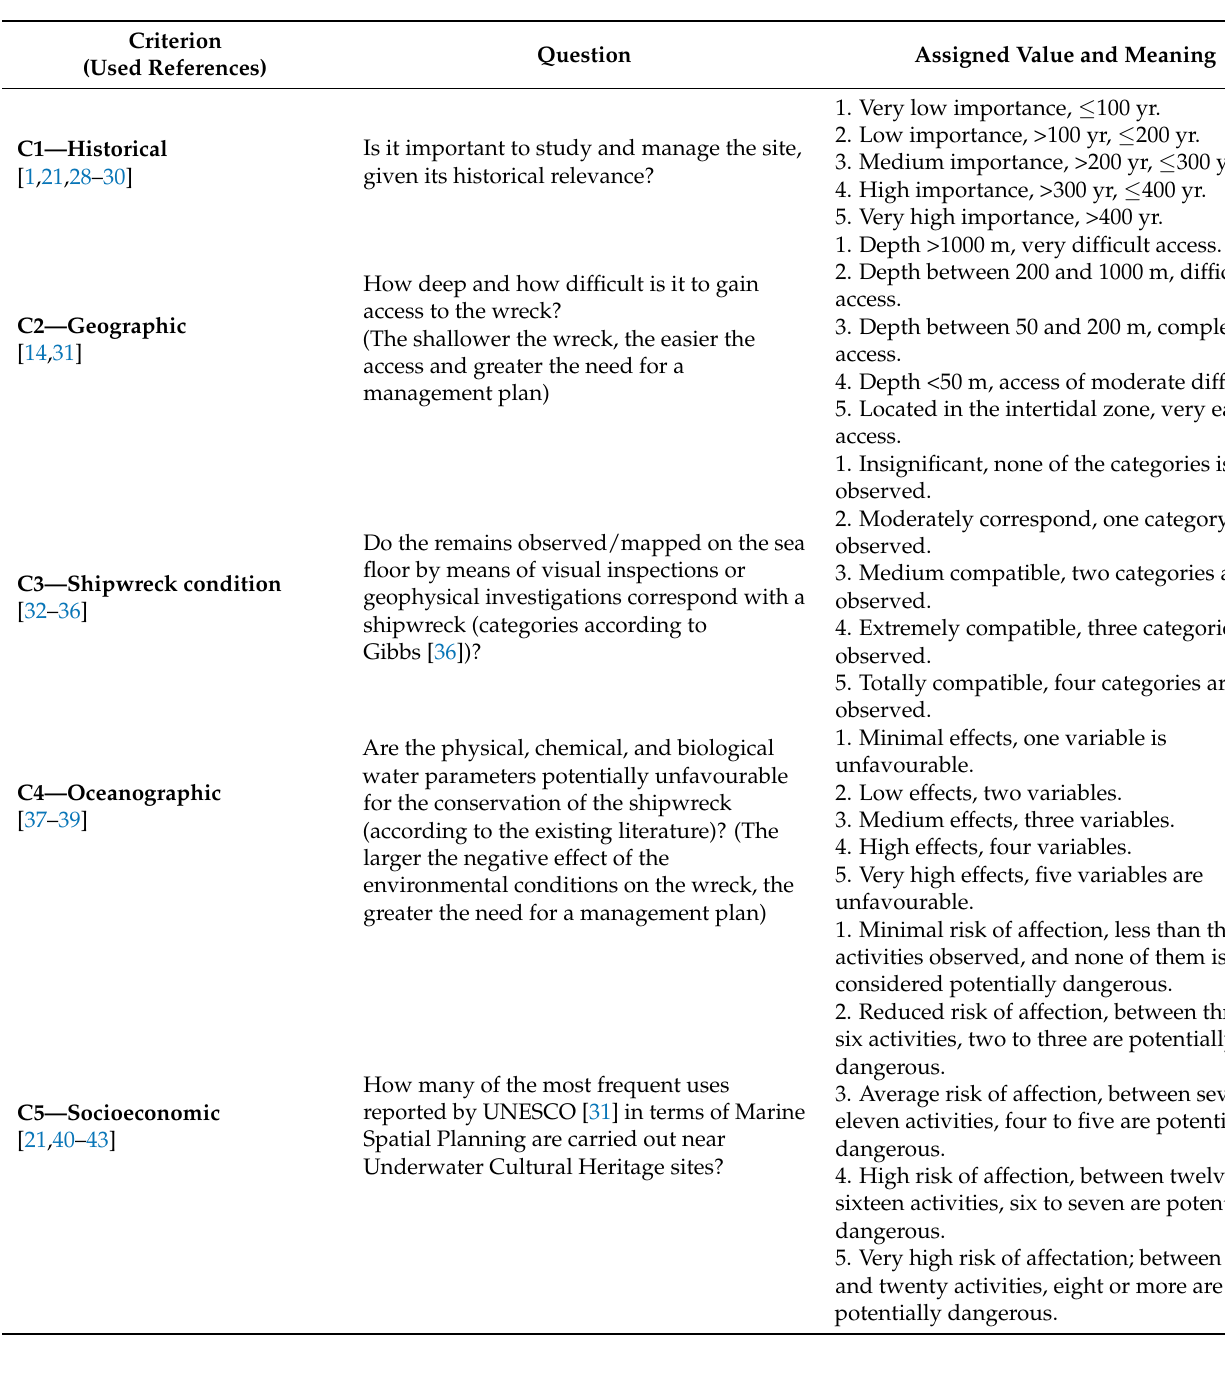
Table 1. Methodological approximation used to decide actuations to manage submerged cultural heritage sites